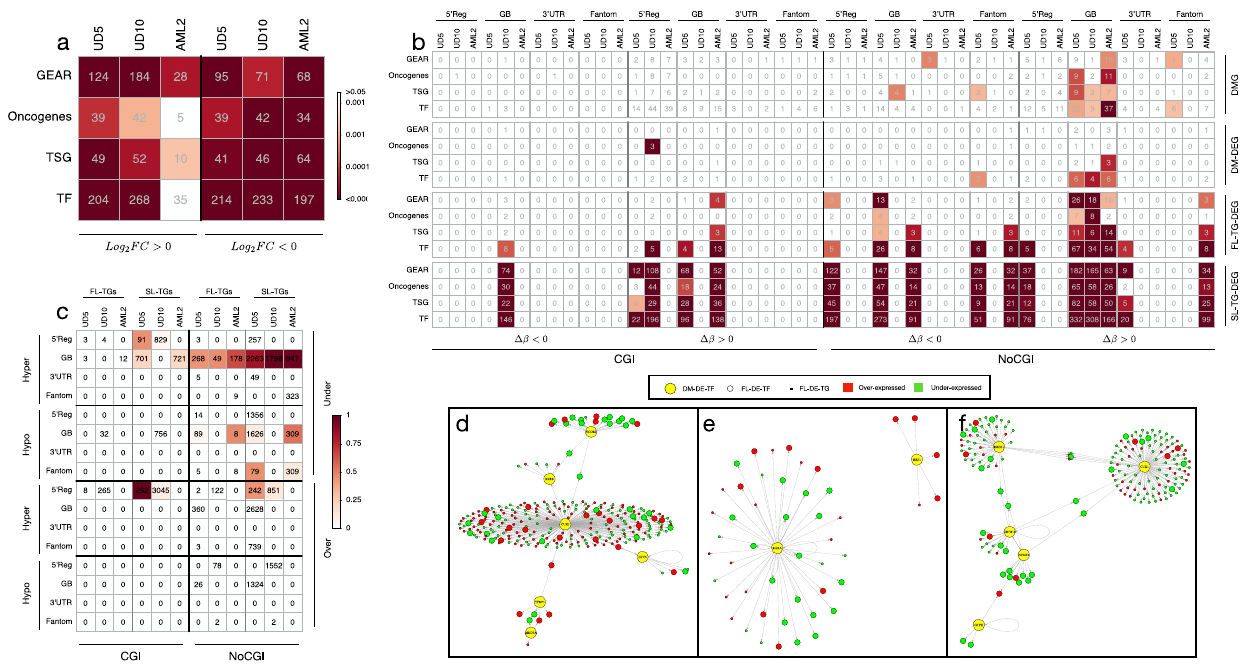
Fig. 3 Impact of DMRs on gene expression. a , b Show the results of ORA on DEGs ( a ), DMGs, under-expressed DM-DEGs, FL- and SL-TG-DEGs ( b ) for GEAR, Oncogenes, TSG and TF categories. Each cell of the plots reports the number of genes for each category. For both panels a-b color of each cell re fl ects the statistical signi fi cance expressed by Fisher exact test as in the color legend. c Reports the total number of DE-TGs of the fi rst- (FL-) and second-level (SL-) regulatory cascade induced by over- and under-expressed TFs with hyper- or hypo-methylated DMRs (DM-DE-TF) in CpG islands (CGI) and sparse CpG regions (NoCGI) at different genomic elements (5' regulatory region, Reg, internal introns and exons, GB, 3'UTR and enhancers of Fantom Genes). In each cell of the table is reported the number of DE-TGs for each regulatory category. For each sample, color of each cell re fl ects the proportion of DE-TGs shared with the other two samples. d – f Show GRNs induced by under-expressed DM-DE-TFs with DMRs at sparse CpG regions of the gene- body for UD5 ( d ), UD10 ( e ) and AML2 ( f ). Yellow large-size nodes are DM-DE-TFs, medium-size nodes are FL-DE-TFs and small-size nodes are FL-DE- TGs. Green nodes represent under-expressed TGs, while red nodes over-expressed